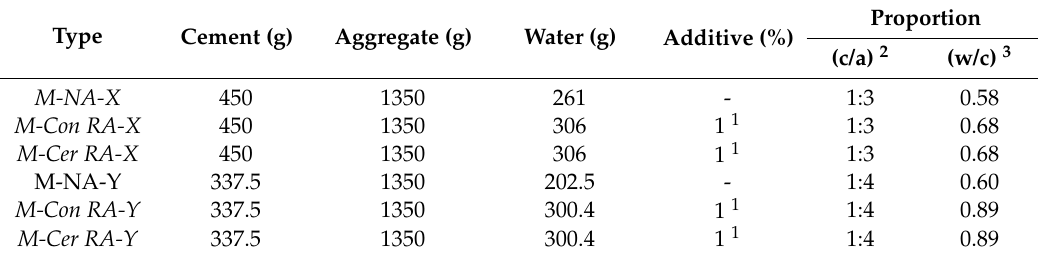
Table 1. Mortars